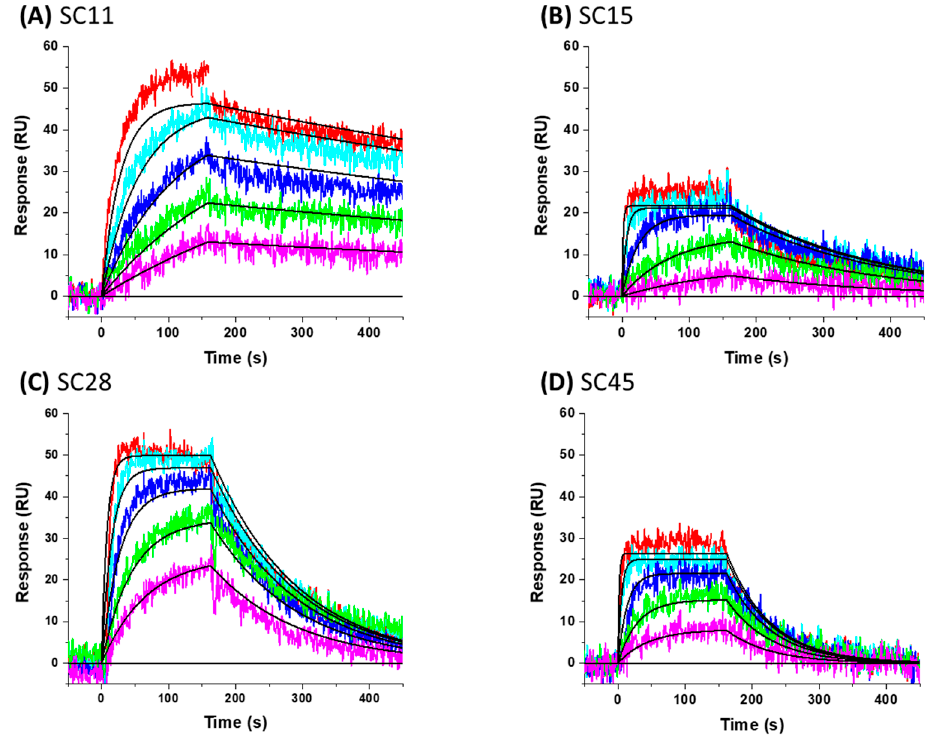
Figure 2. Sensorgrams showing the interaction of small molecule compounds with B41 SOSIP.664 gp140 trimer immobilized on the sensor chip. ( A ) SC11 (concentrations shown are 10 µM and down in a 1:2 dilution series), ( B ) SC15 (2 µM, 1:4 dilution series), ( C ) SC28 (10 µM, 1:2 dilution series), and ( D ) SC45 (40 µM, 1:3 dilution series). Colored lines represent actual data collected from the dilution series, whereas black lines signify the fits to a 1:1 binding model. Interaction parameters derived from 5 sets of data are given in Table 1. Table 1. Kinetics and affinity of compounds SC11 , SC15 , SC28 , and SC45 binding to B41 SOSIP.664 gp140 trimer.